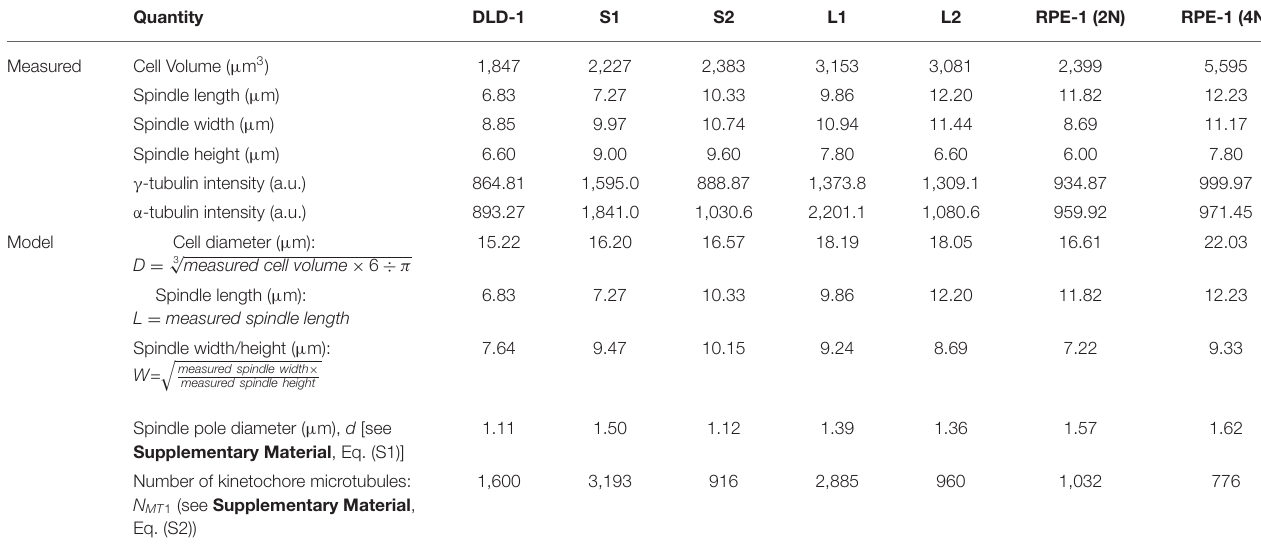
TABLE 1 | Median values of measured quantities in cell clones and parameters used in the model. Quantity DLD-1 S1 S2 L1 L2 RPE-1 (2N) RPE-1 (4N) Measured Cell Volume ( µ m 3 )